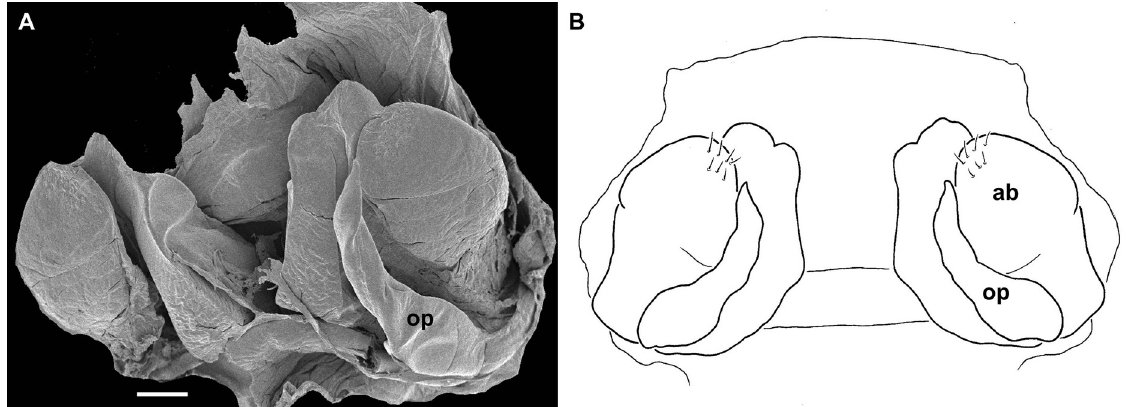
Fig. 7. Sechelleptus arborivagus sp. nov., paratype, ♀ (BE_RMCA_MYR.Dip.22876) . Vulva. A . SEM of the vulva removed from the body, caudal view, slightly lateral. B . Drawing of the vulva, caudal view. Abbreviations: ab = aboral valve; op = opercula. Scale bar = 100